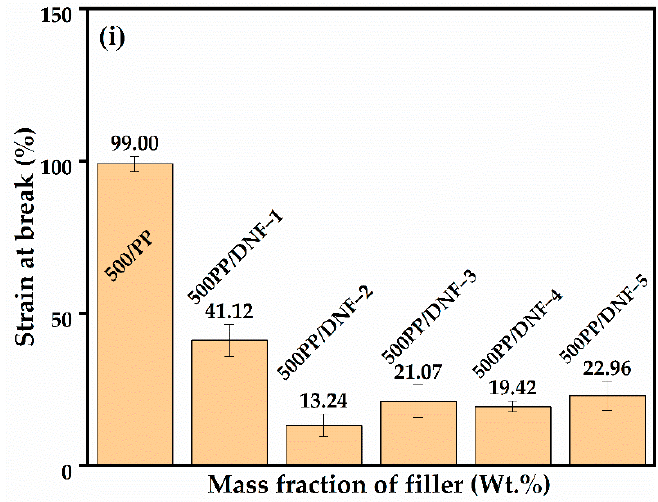
Figure 5. Mechanical properties of composite samples. ( a ) Tensile strength of PP/DNF samples; ( b ) strain at yield (%) of PP/DNF; ( c ) strain at break (%) of PP/DNF; ( d ) tensile strength of 250PP/DNF samples; ( e ) strain at yield (%) of 250PP/DNF; ( f ) strain at break (%) of 250PP/DNF; ( g ) tensile strength of 5000PP/DNF samples; ( h ) strain at yield (%) of 500PP/DNF; ( i ) strain at break (%) of 500PP/DNF samples.